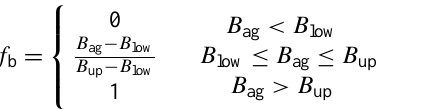
Fig. 3. Dependence of fire occurrence on (a) fuel availability f b , (b) relative humidity f RH , and (c) soil wetness f θ